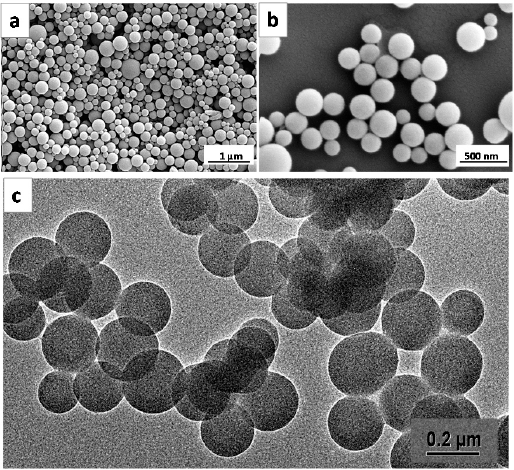
Figure 3. SEM images of a chiral PMO system prepared from ligand ( 3 ) with ( a , b ) CTAB and ( c , d ) CTAC surfactants.